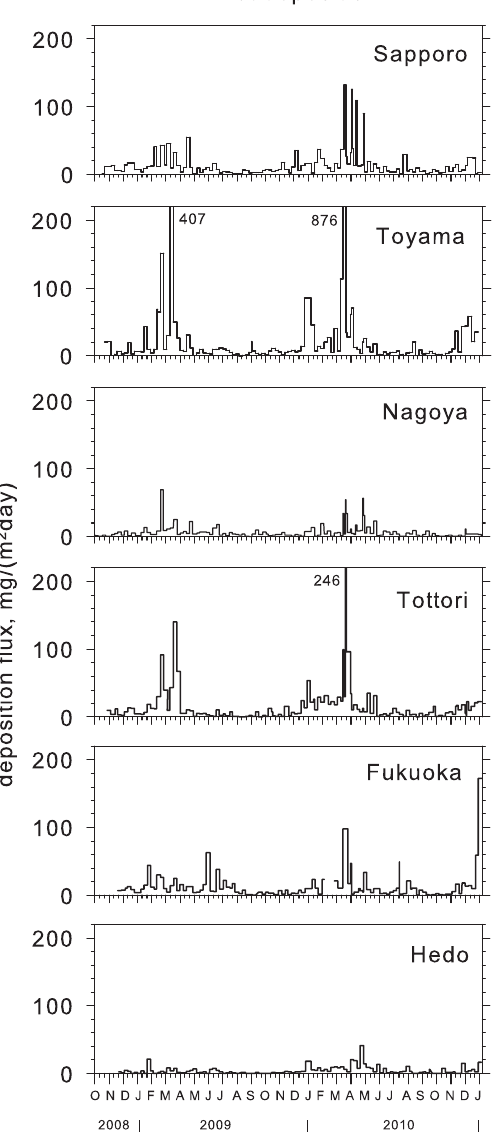
Fig. 2. Wet deposition flux (mgm − 2 day − 1 ) of mineral dust